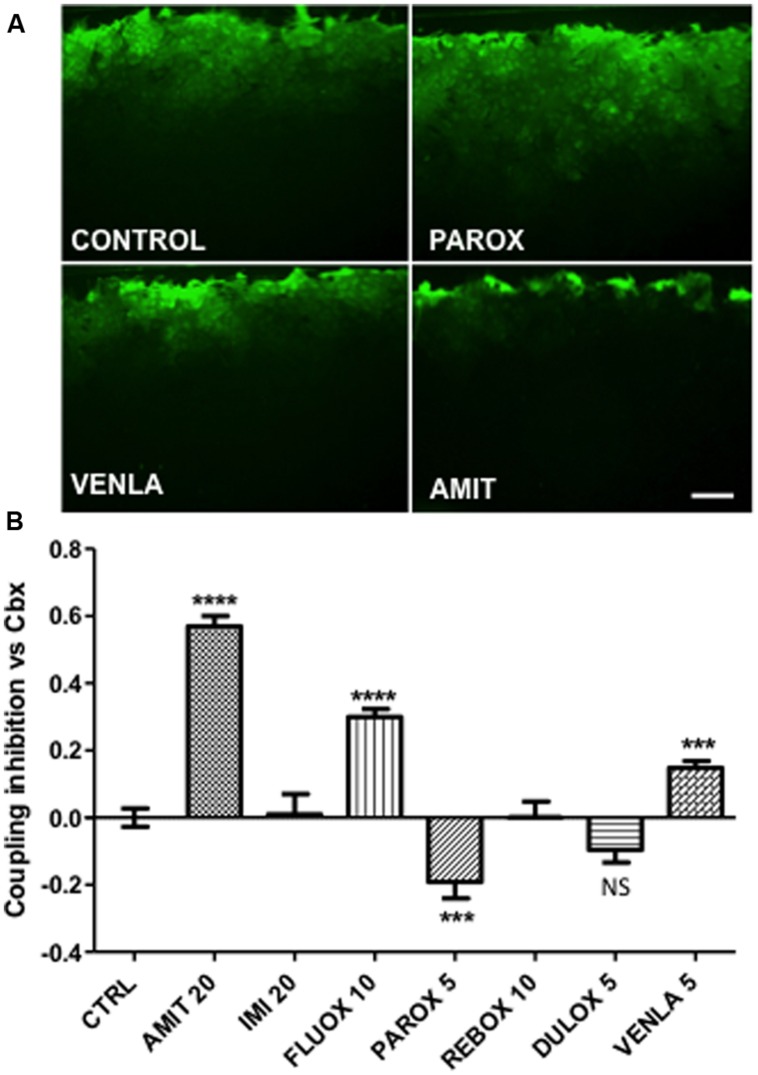
Modulation of astrocyte Cx43 gap junctional communication after 24-h treatment by seven antidepressants in mice cortical astrocyte cultures. Amitriptyline (AMIT), imipramine (IMI), fluoxetine (FLUOX), paroxetine (PAROX), reboxetine (REBOX), duloxetine (DULOX), and venlafaxine (VENLA) were added from 5 to 20 μM in cellular medium during 24 h, gap junctional communication was evaluated by the scrape loading dye transfer method. (A) Pictures of control, paroxetine 5 μM, venlafaxine 5 μM, and amitriptyline 20 μM, illustrate the Lucifer yellow spreading through astrocyte gap junctions for these different treatments. (B) Summary diagram of junctional communication in vehicle-treated cells (control group) and after antidepressant treatment. Note that the values are normalized to carbenoxolone (50 μM, 24 h). Data are the means ± SEM n = 3–7 per group, ∗∗∗p < 0.001, ∗∗∗∗p < 0.0001 vs. control, Kruskal–Wallis test and one-way ANOVA followed, respectively, by Dunn and Bonferroni post test. Scale bar 20 μM.